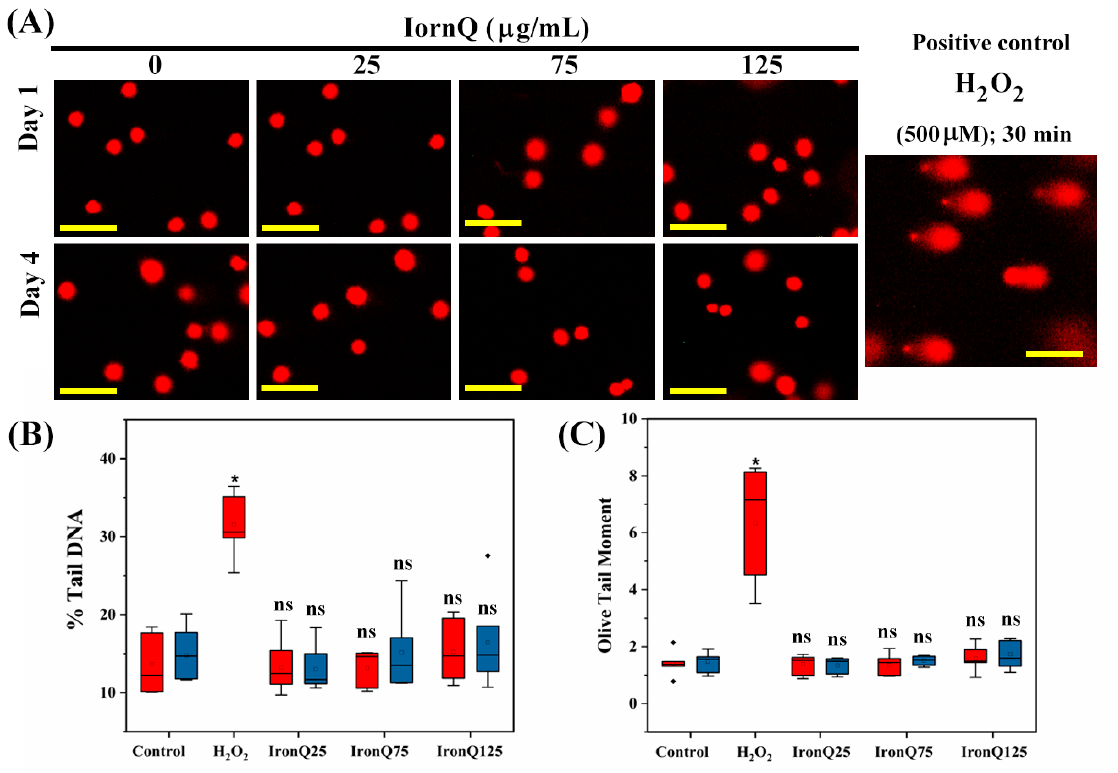
Figure 4. DNA damage assessment of PBMCs after labeling with IronQ by comet assay. ( A ) Representative comet images of PBMCs treated with different concentrations of IronQ for an incubation period of 24 and 96 h. ( B ) Bar diagram showing the assessment in % of DNA in the tail. ( C ) Bar diagram showing the assessment in olive tail moment. Data are expressed as mean ± SD of eight independent samples. A significant increase in DNA damage parameters after PBMC exposure to H 2 O 2 served as a positive control compared to control PBMCs. However, there was no significant difference in the IronQ treatment groups compared to controls. Asterisks indicate significance (* p < 0.05), and ns is not significant, as compared to the control.